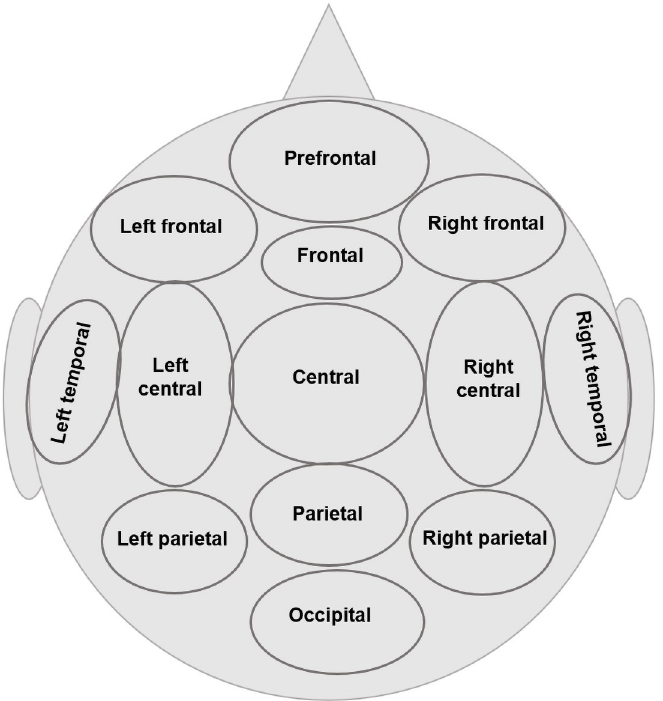
Fig 1. Reduction scheme into 13 major topographic brain regions. Prefrontal—Fp1, Fp2; Left frontal—F7, F3; Right frontal—F4, F8, Frontal–Fz; Central—Cz, Cp1, Cp2, Fc1, Fc2; Parietal–Pz, Left temporal—T7; Right temporal—T8; Left central—C3, Fc5, Cp5; Right central—C4, Fc6, Cp6; Left parietal—P7, P3, Po3; Right parietal—P4, P8, Po4; Occipital—O1, O2,